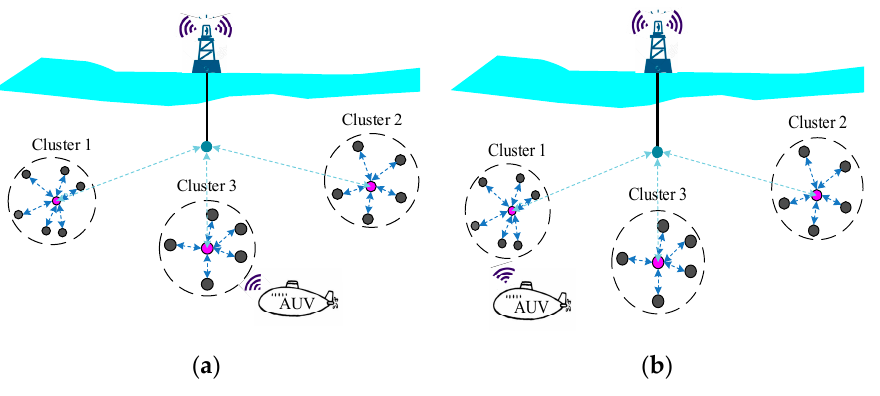
Figure 2. Cluster UWSNs with autonomous underwater vehicles (AUVs); ( a ) AUV joins Cluster3; ( b ) AUV joins Cluster1.